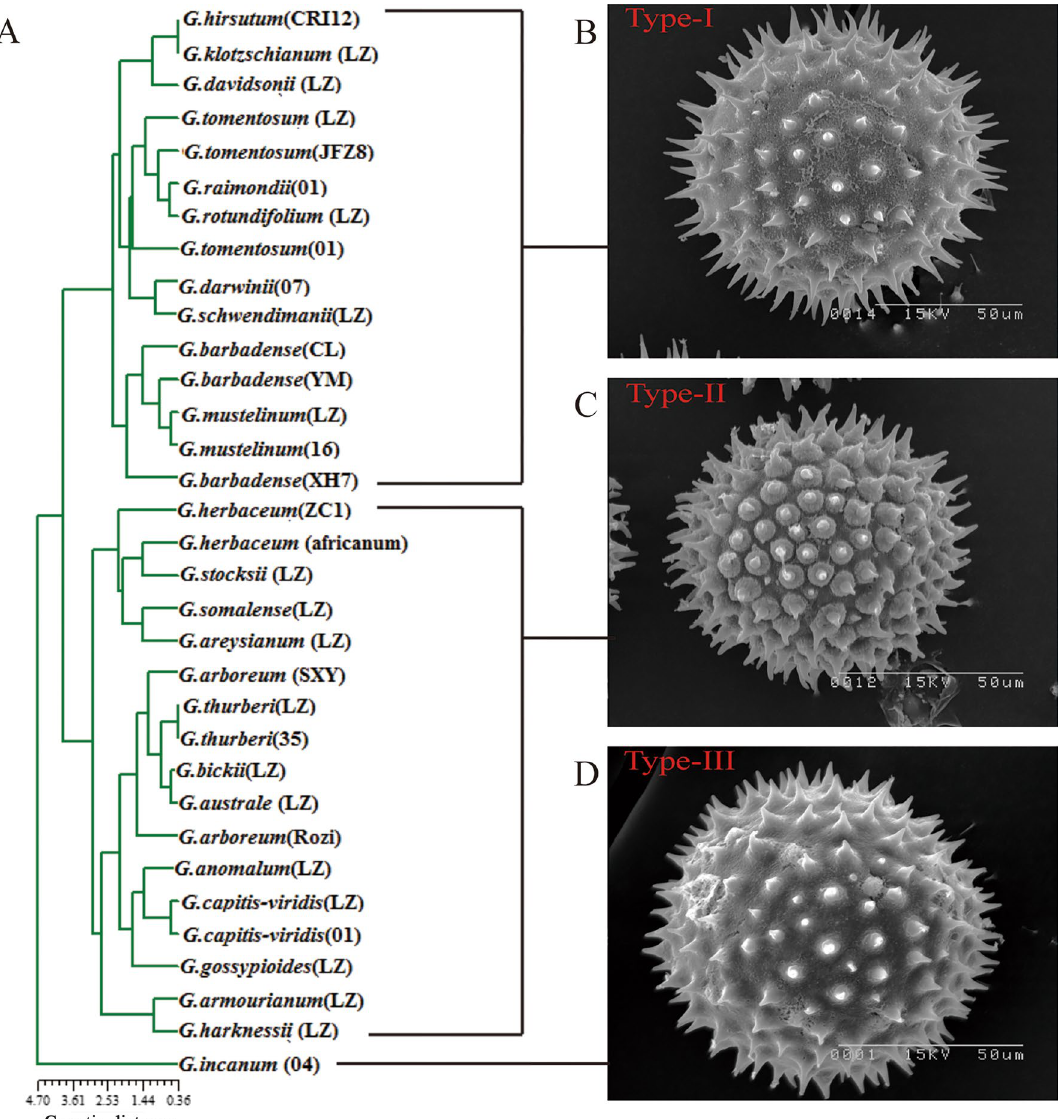
Fig. 4 Dendrogram of Gossypium based on pollen characteristics ( A ). Three pollen types (right): Type I, big pollen size, long spine length, low spine density and little protuberance ( B ); Type II, small pollen size, short spine length, low spine density, and obvious protuberance ( C ); Type III, small pollen size, short spine length, high spine density, and little protuberance ( D ). Scale bar: 50 μm. Accelerating voltage: 15